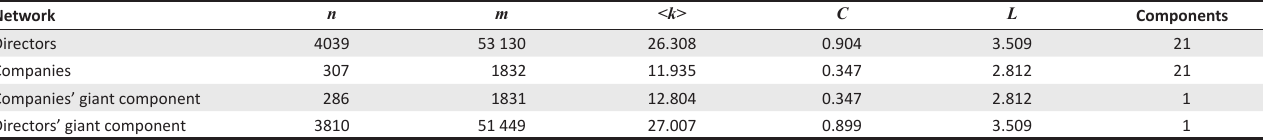
TABLE 1: Macro-level statistics for the Johannesburg Stock Exchange company director network. Network n m